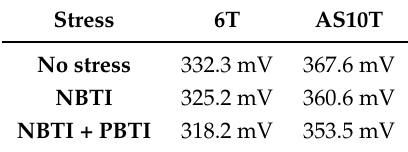
Table 2. HSNM of different SRAM cells with and without BTI after the stress time of three